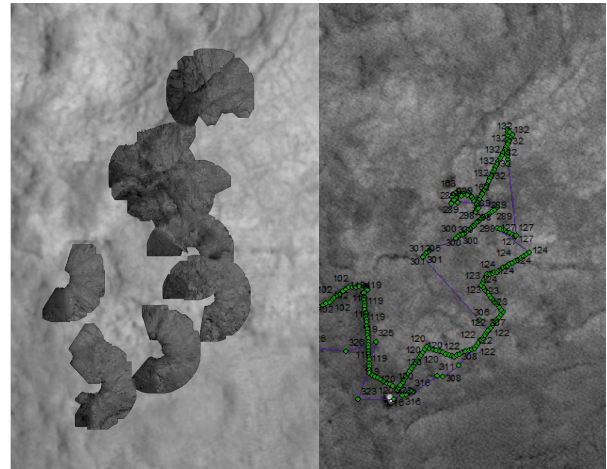
Figure 6 Example of co-registered wide baseline NavCam ORI mosaic and HiRISE ORI (left) and corrected traverse (right) for MSL from Sol 120 to Sol 179